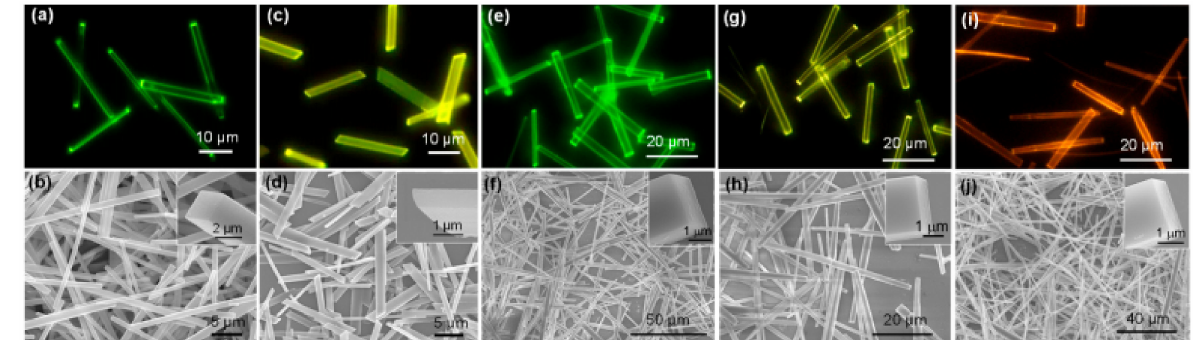
Figure 6. ( a , c , e , g , i ) Fluorescence microscopy images and ( b , d , f , h , j ) SEM images of microcrystals of ( a , b ) 21-g (R 1 = R 2 = C 6 H 5 ; R 3 = Me; R 4 = R 6 = F; R 5 = H) ( c , d ) 21-y (R 1 = R 2 = C 6 H 5 ; R 3 = Me; R 4 = R 6 = F; R 5 = H) ( e , f ) 21 (R 1 = R 2 = C 6 H 5 ; R 3 = Me; R 4 = F; R 5 = R 6 = H), ( g , h ) 21 (R 1 = R 2 = C 6 H 5 ; R 3 = Me; R 4 = R 6 = H; R 5 = F, and ( i , j ) 21 (R 1 = R 2 = C 6 H 5 ; R 3 = Me; R 4 = R 5 = H; R 6 = F). The inset shows enlarged SEM images of the ends of microrods. Reproduced with permission from ref.